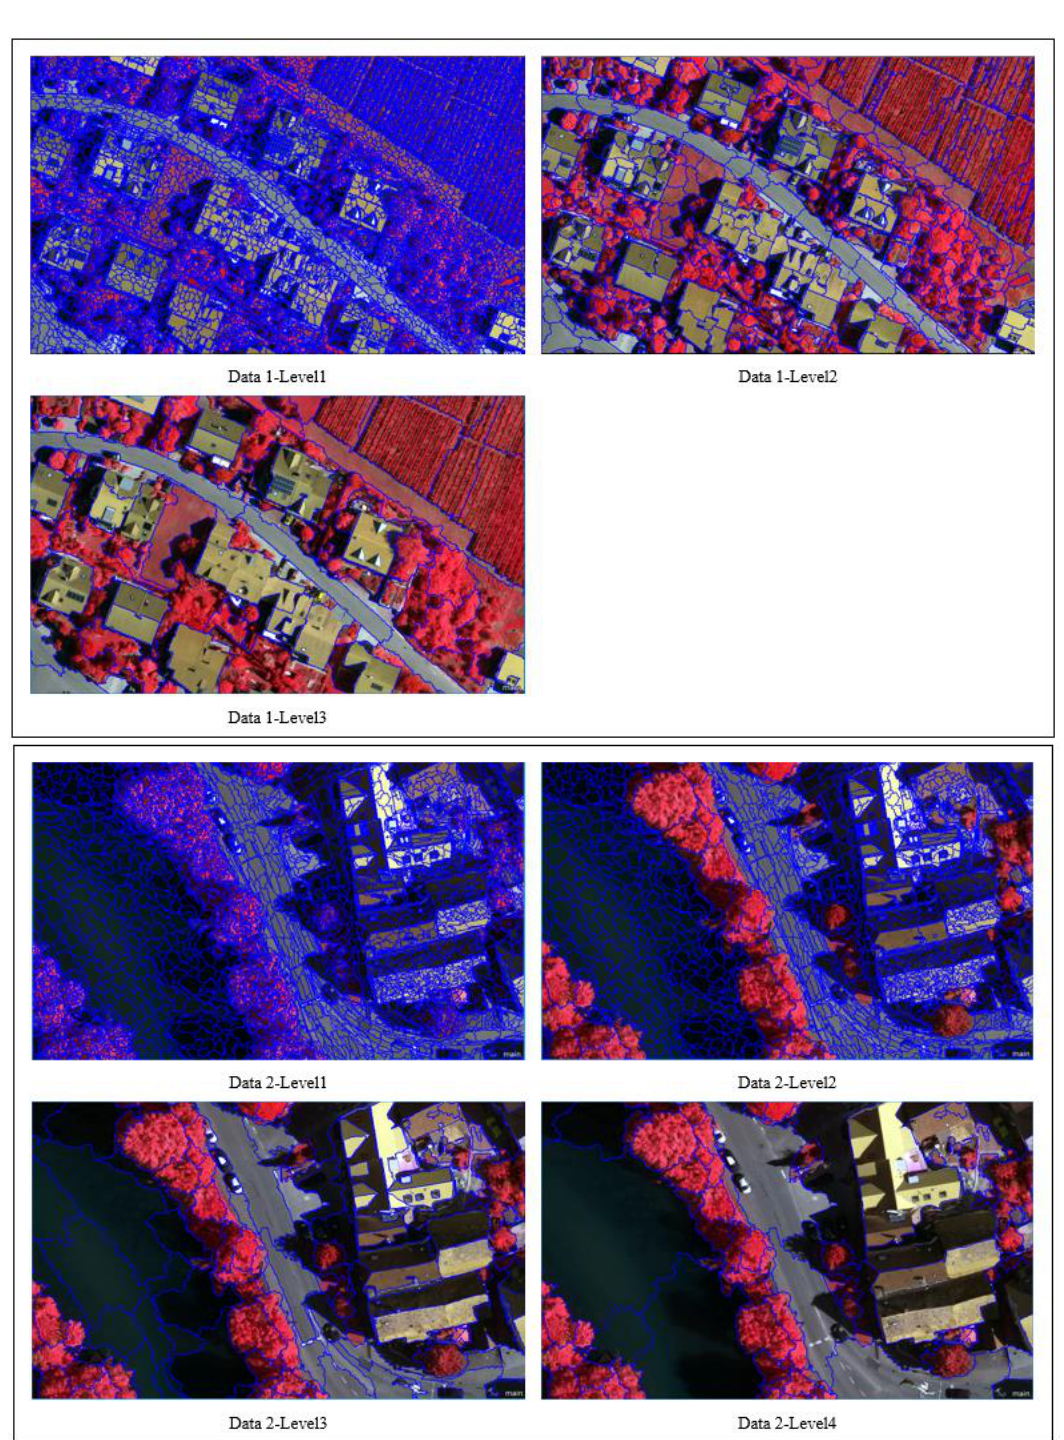
Figure 5. Multiresolution segmentation results of Level 1, Level 2, Level 3, and Level 4 for Data 1 and Data 2